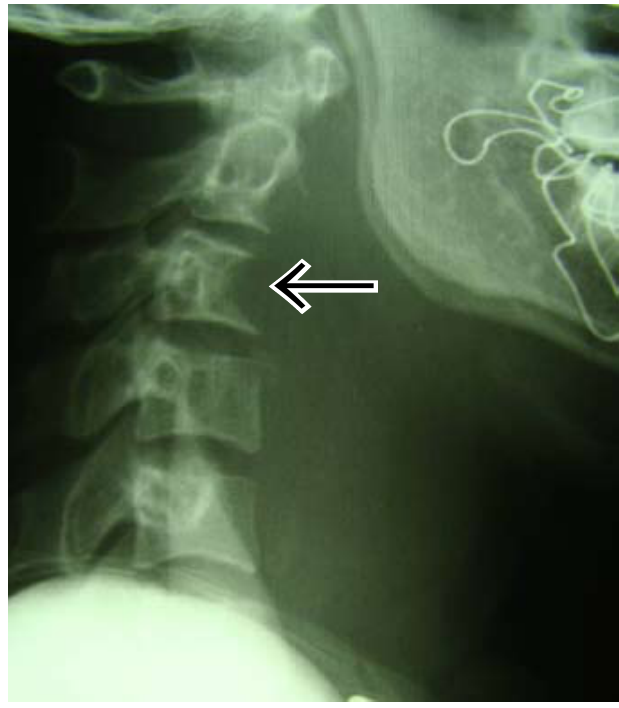
Fig. 16d. Lateral view of the cervical spine with a large anterior soft-tissue neurofibroma causing pressure erosion of the anterior margin of C3.